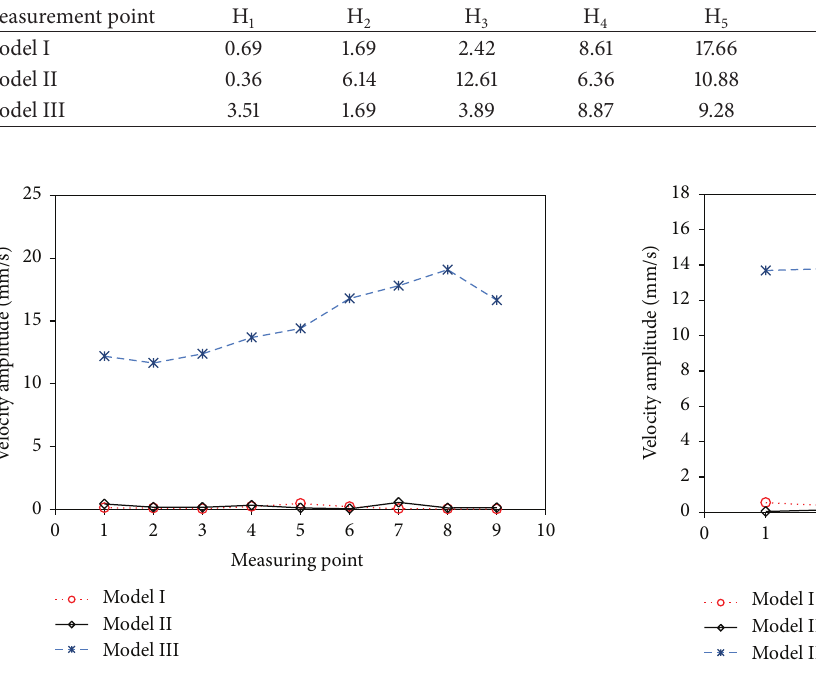
Figure 8: Velocity intensities of V 1 –V 7 for Models I, II, and III subjected to base excitation at 100Hz.